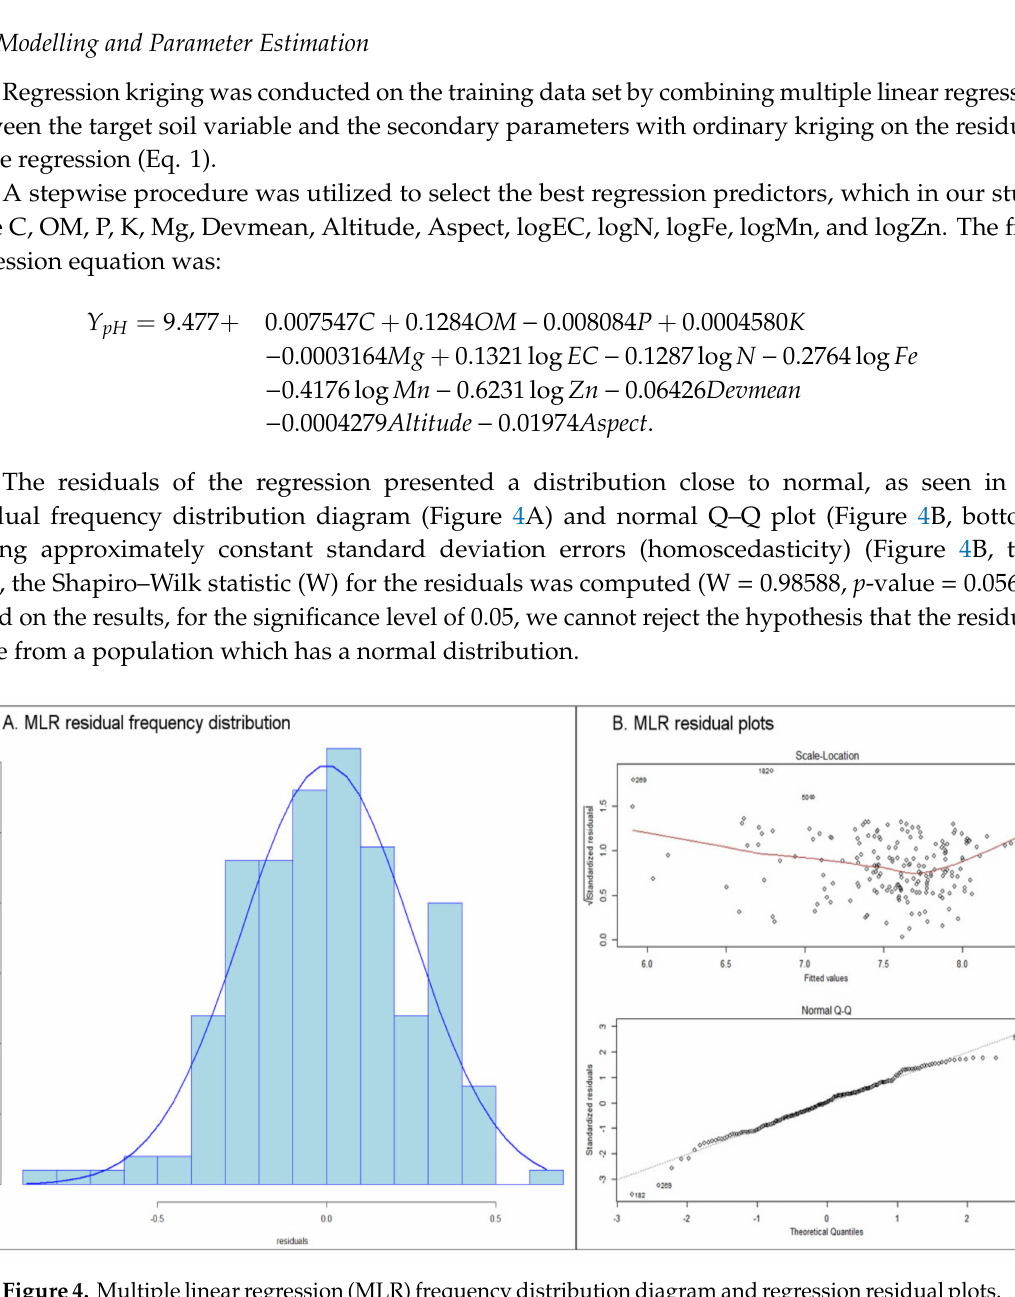
Figure 4. Multiple linear regression (MLR) frequency distribution diagram and regression residual